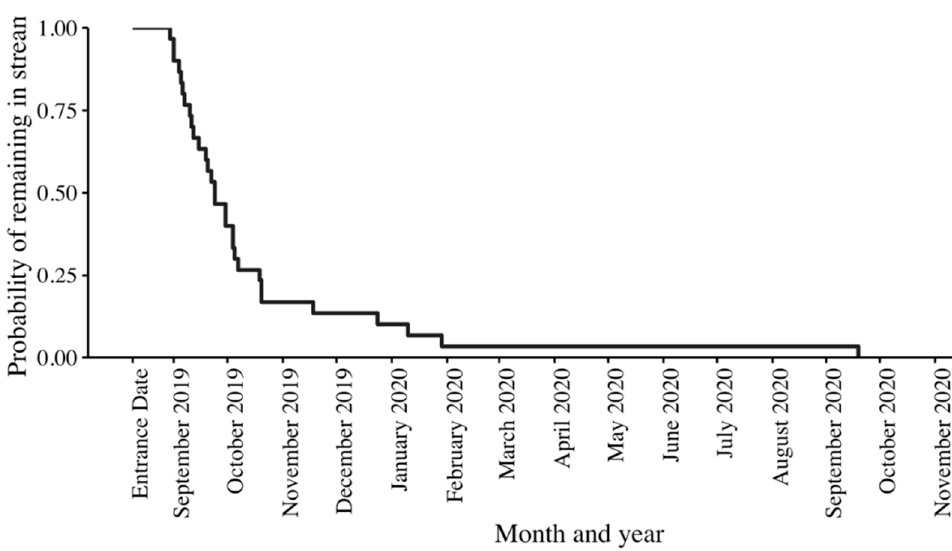
Figure 5. Probability of remaining in Graves Creek, Montana, for juvenile bull trout from the 2017 year-class initially encountered at age 2 (n = 30). Table 2. Summary of the sample population of bull trout in Graves Creek, Montana, following electrofishing in the summer of 2019 and summer of 2020. Summer sampling numbers indicate the total number of bull trout sampled, with the number of tagged bull trout in parenthesis. Density is the mean overall density of each year-class during the summer sampling season. Autumn out-migrants are tagged bull trout that out-migrated during the autumn out-migration events in 2019 (4